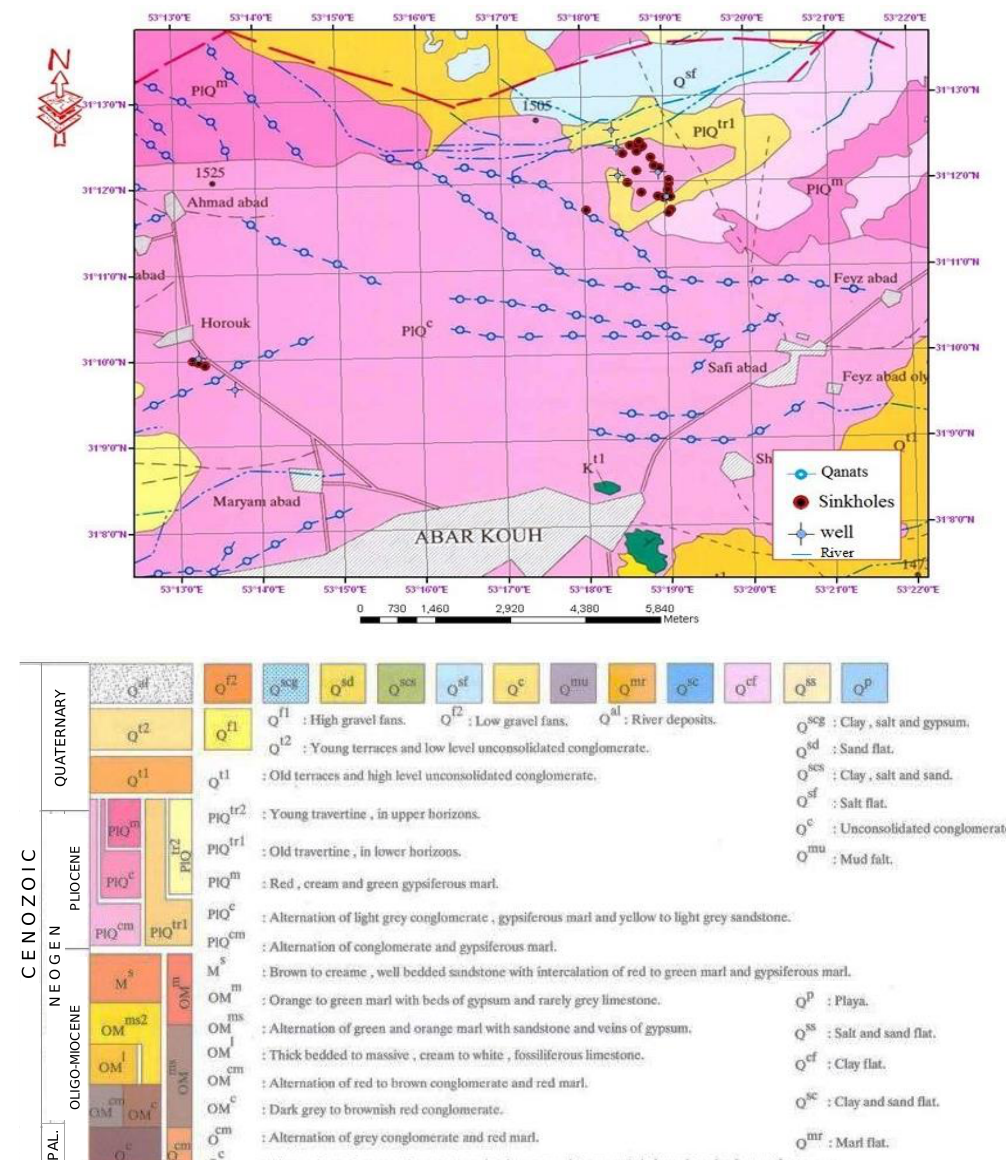
Figure 5. Detailed view of the location of sinkholes with geological map around sinkholes near Feizabad